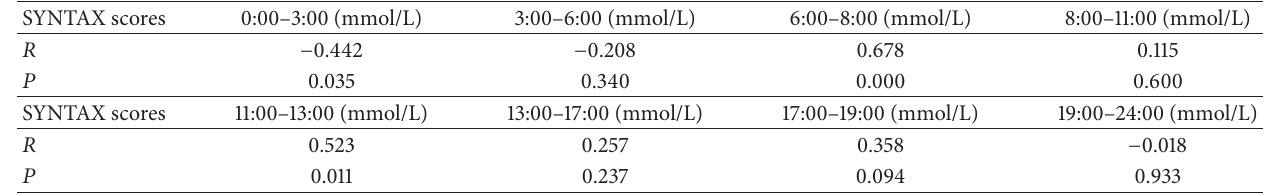
Table 3: Correlation analysis between SYNTAX scores and the blood glucose excursion of different time sessions in group C. SYNTAX scores